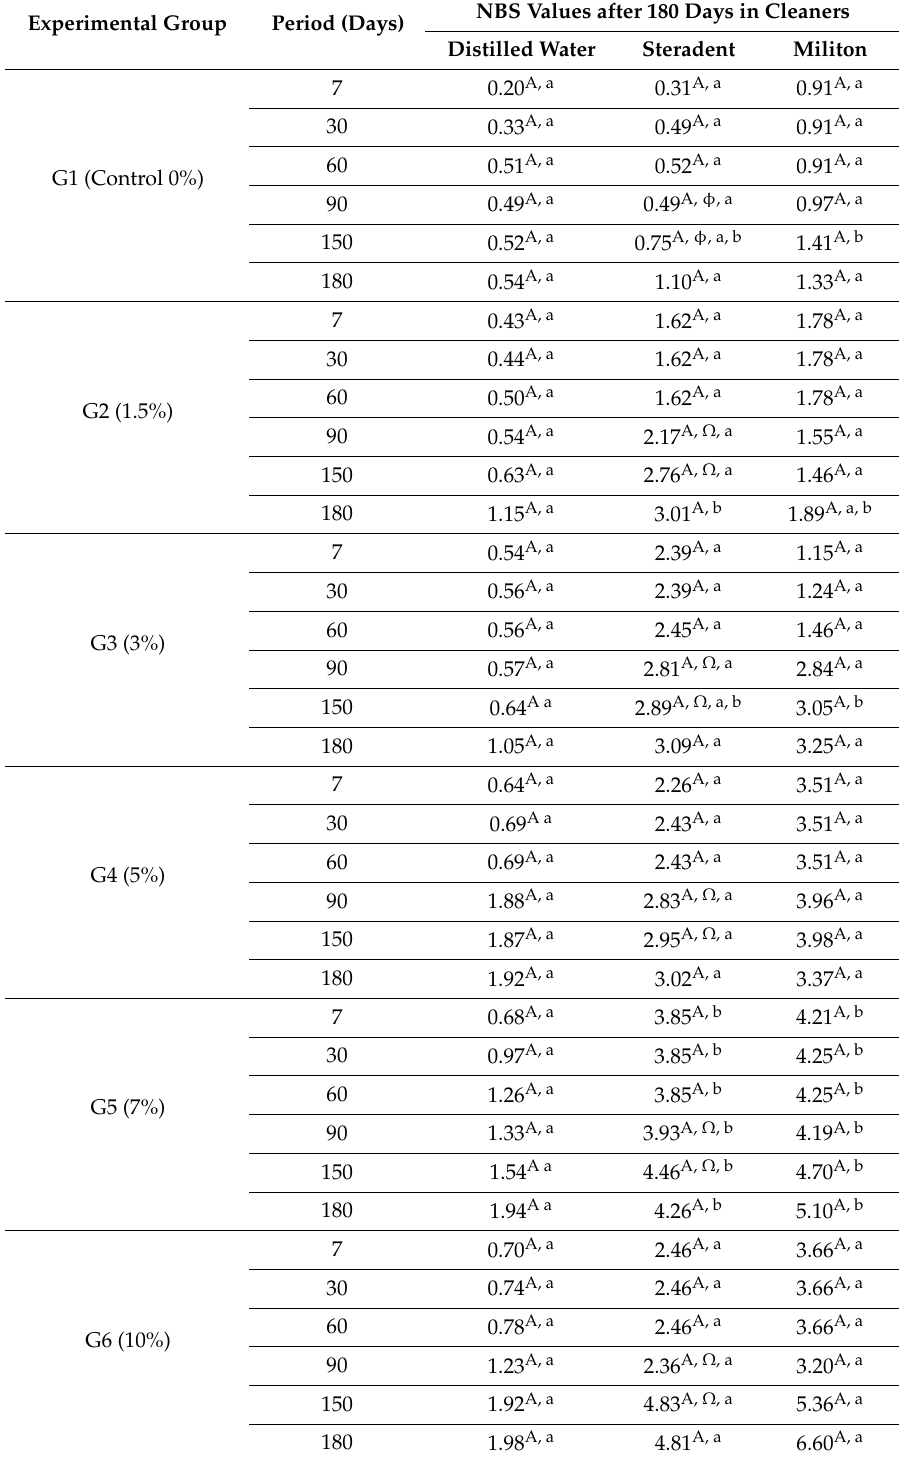
Table 5. The median colour change values and statistical di ff erences of specimens following immersion in STD and MIL compared to DW for 180